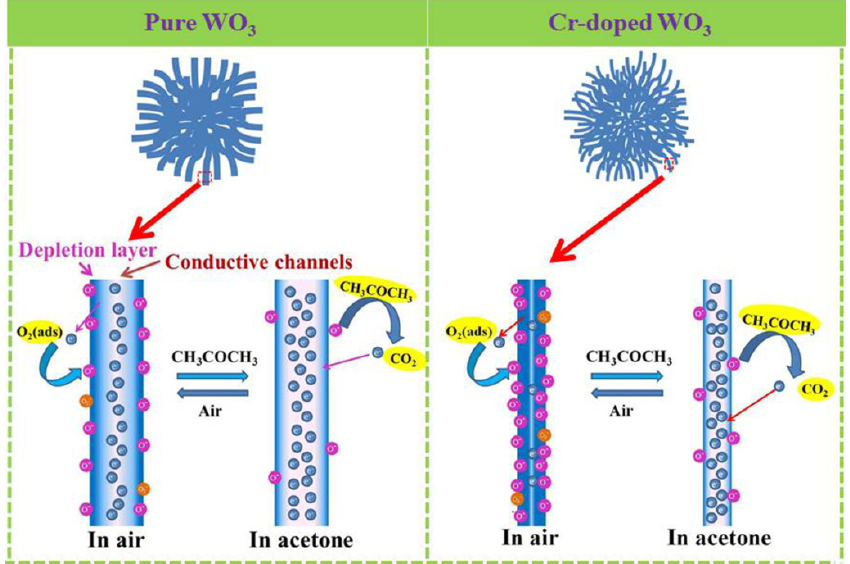
Figure 12. Representative models for acetone sensing mechanisms of: ( a ) pure and ( b ) Cr-doped WO 3 at 250 °C.